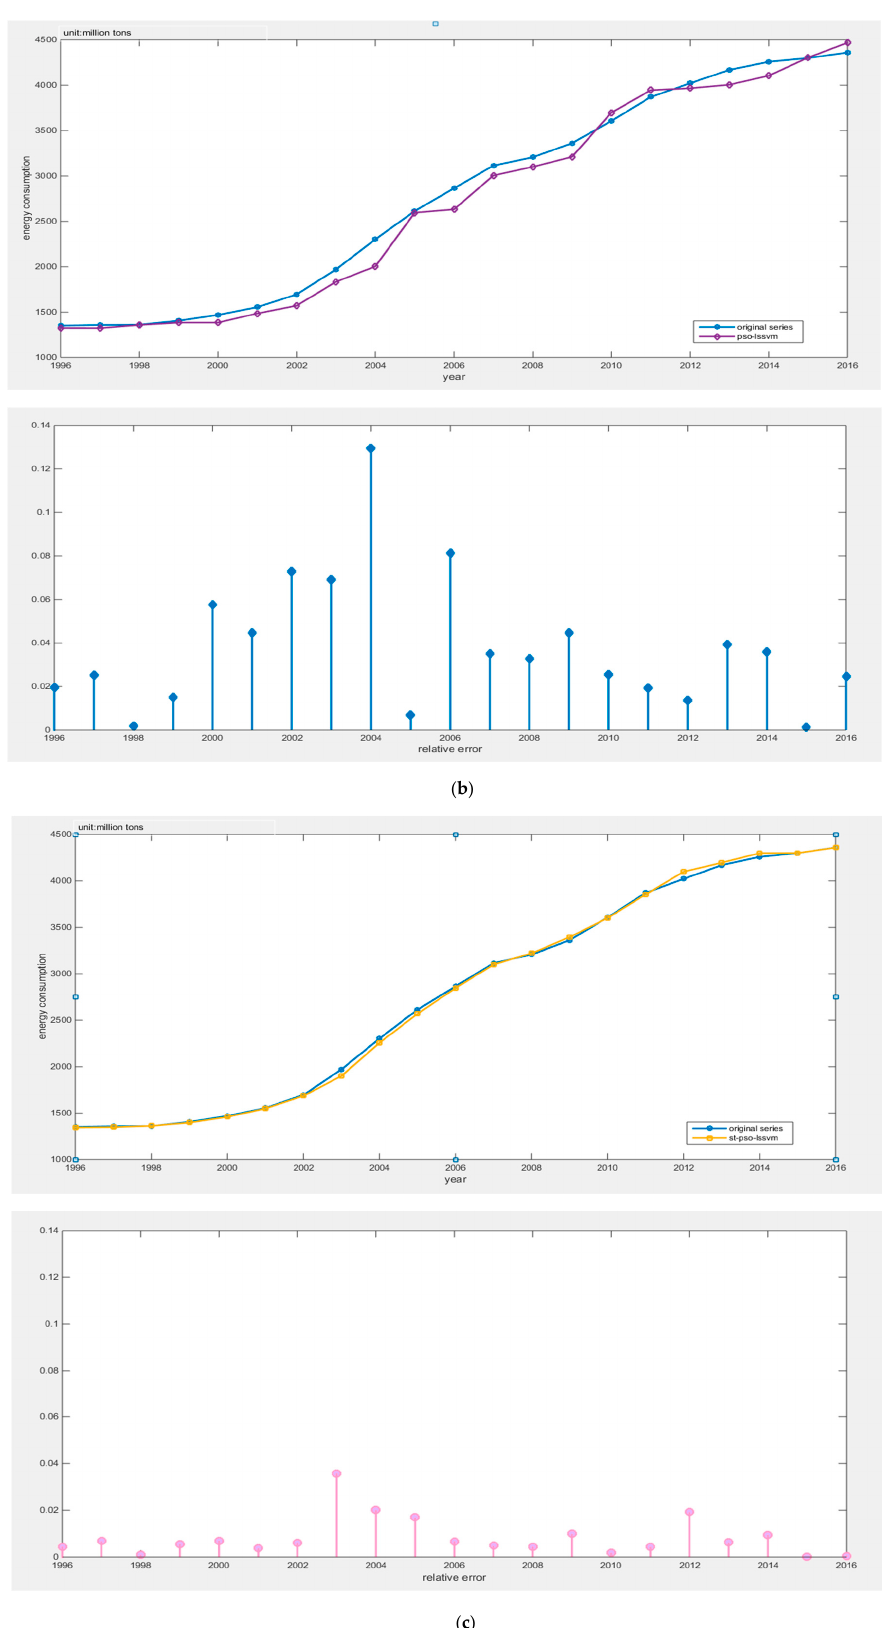
Figure 5. Comparison of the three forecasting models: ( a ) forecasting results of LSSVM model; ( b ) forecasting result of PSO-LSSVM model; ( c ) forecasting result of TS-PSO-LSSVM model. The correlation error (RE) of the three forecasting results are shown in Table 5.